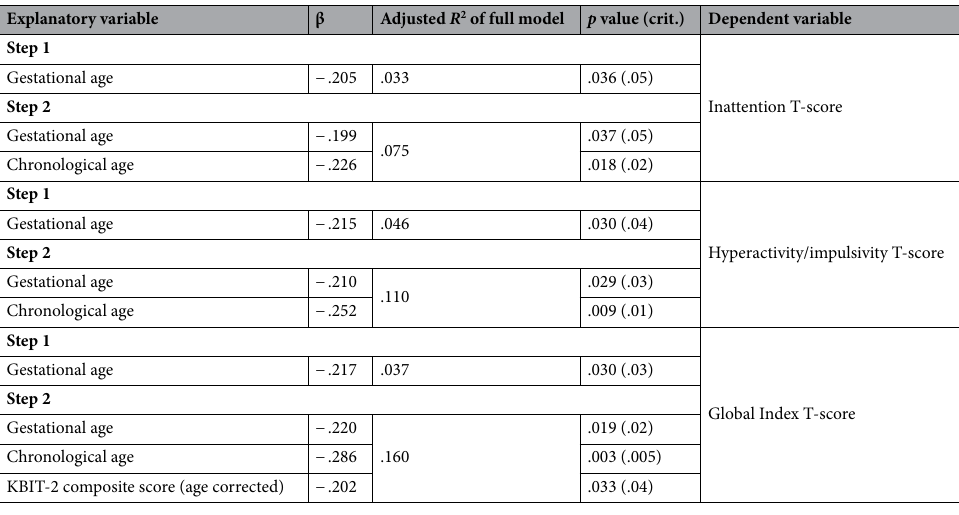
Table 4. Gestational age associated with ADHD symptoms while adjusting for demographic factors: results from Stepwise Regression Analyses excluding those participants with DS taking ADHD medication (n = 88). Chronological age and KBIT-2 composite score of participants with Down syndrome are at time of ADHD measurement. FDR-adjusted critical values are presented next to p values, if a p value is below or at the critical value it remains significant after controlling for multiple